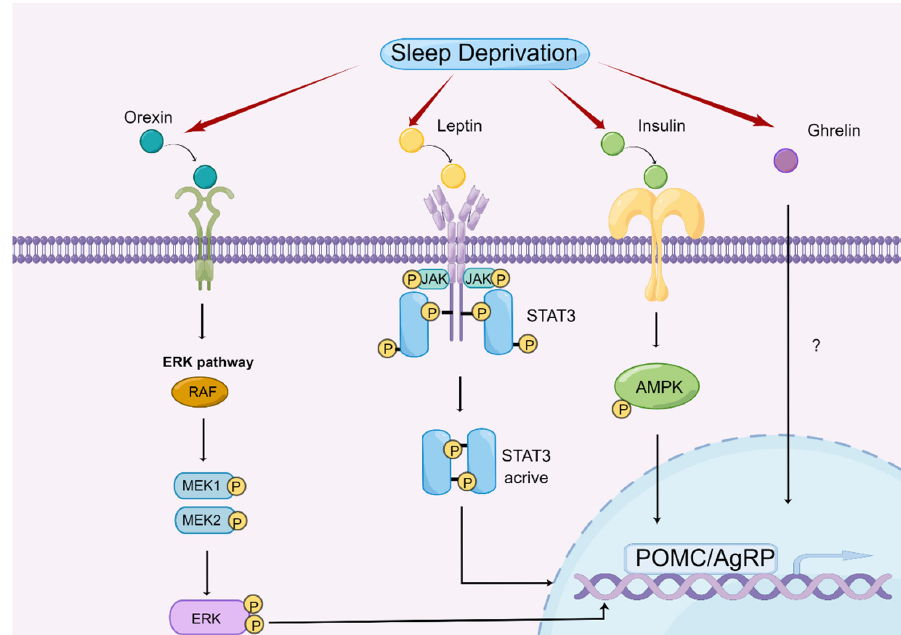
Figure 2. Central regulatory mechanism of appetite by sleep deprivation. Mechanisms of sleep dep- rivation on the regulation of appetite by affecting orexin, ghrelin, leptin, and insulin (drawn by Fig- draw).